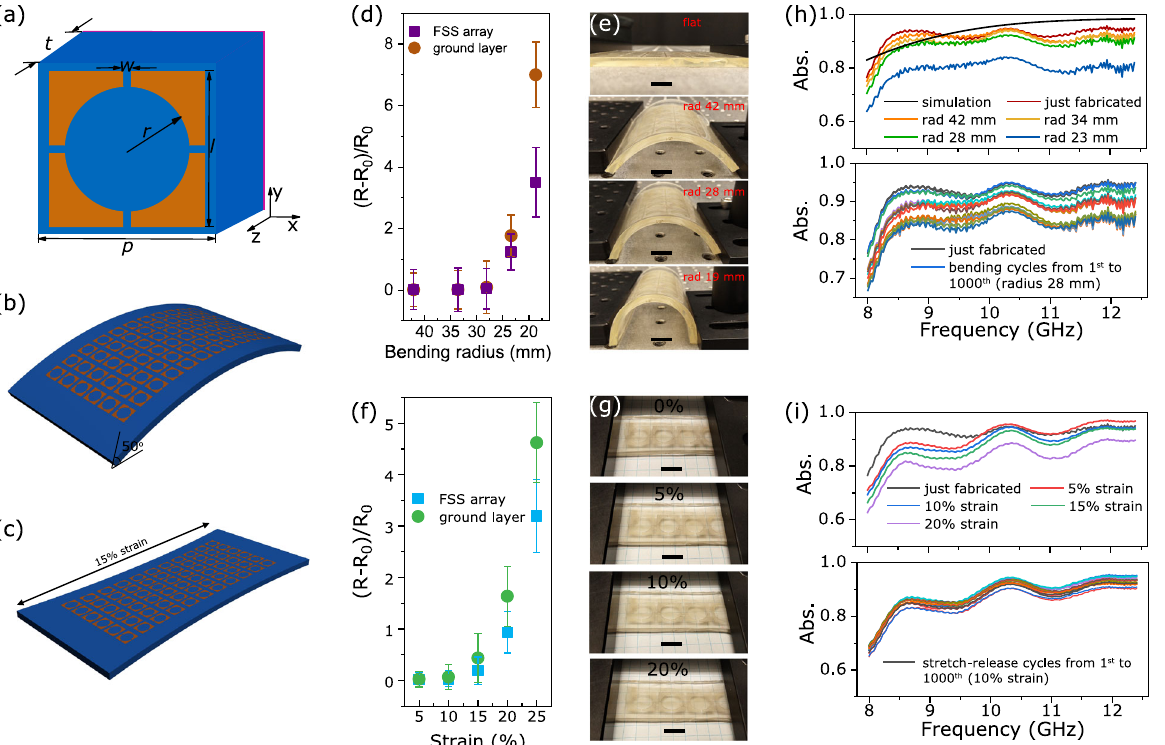
Fig. 4 Properties of the proposed FSS absorbers. a Perspective view of the constructed 3D model of a unit cell of the proposed broadband absorber in CST. The geometry parameters are p = 11 mm, l = 10 mm, r = 4 mm, w = 0.5 mm, and t = 3.5 mm. The dielectric substrate has a permittivity of 2.32 + 0.005 j. The conductivity of the FSS layer (orange) is 200 S/m, corresponding to a sheet resistance of 50 ohm/sq. The ground layer (pink part) has a conductivity of 2.7 × 10 4 S/m. b Schematic illustration of bending the FSS absorber with a bending angle of 50°. c Schematic illustration of stretching the FSS absorber with 15% strain. d The sheet resistance change of the FSS layer and ground layer as a function of bending radiuses ranging from 42 to 19 mm. e Digital images of the FSS absorber bent at different radiuses. The scale bars are 10 mm. f The resistance change in the FSS layer and ground layer as a function of the tensile strain, which ranged from 5 to 25%. g Digital images of the FSS absorber stretched under different tensile strains. The scale bars are 10 mm. h The measured absorptivity of the fabricated absorber under bending radius of 42, 34, 28, and 23 mm (top), and bending cycles from 1 to 1000 with a radius of 28 mm (bottom). i The measured absorptivity of the fabricated absorber under various tensile strains of 5, 10, 15, and 20% (top), and stretching cycles when 10% strain